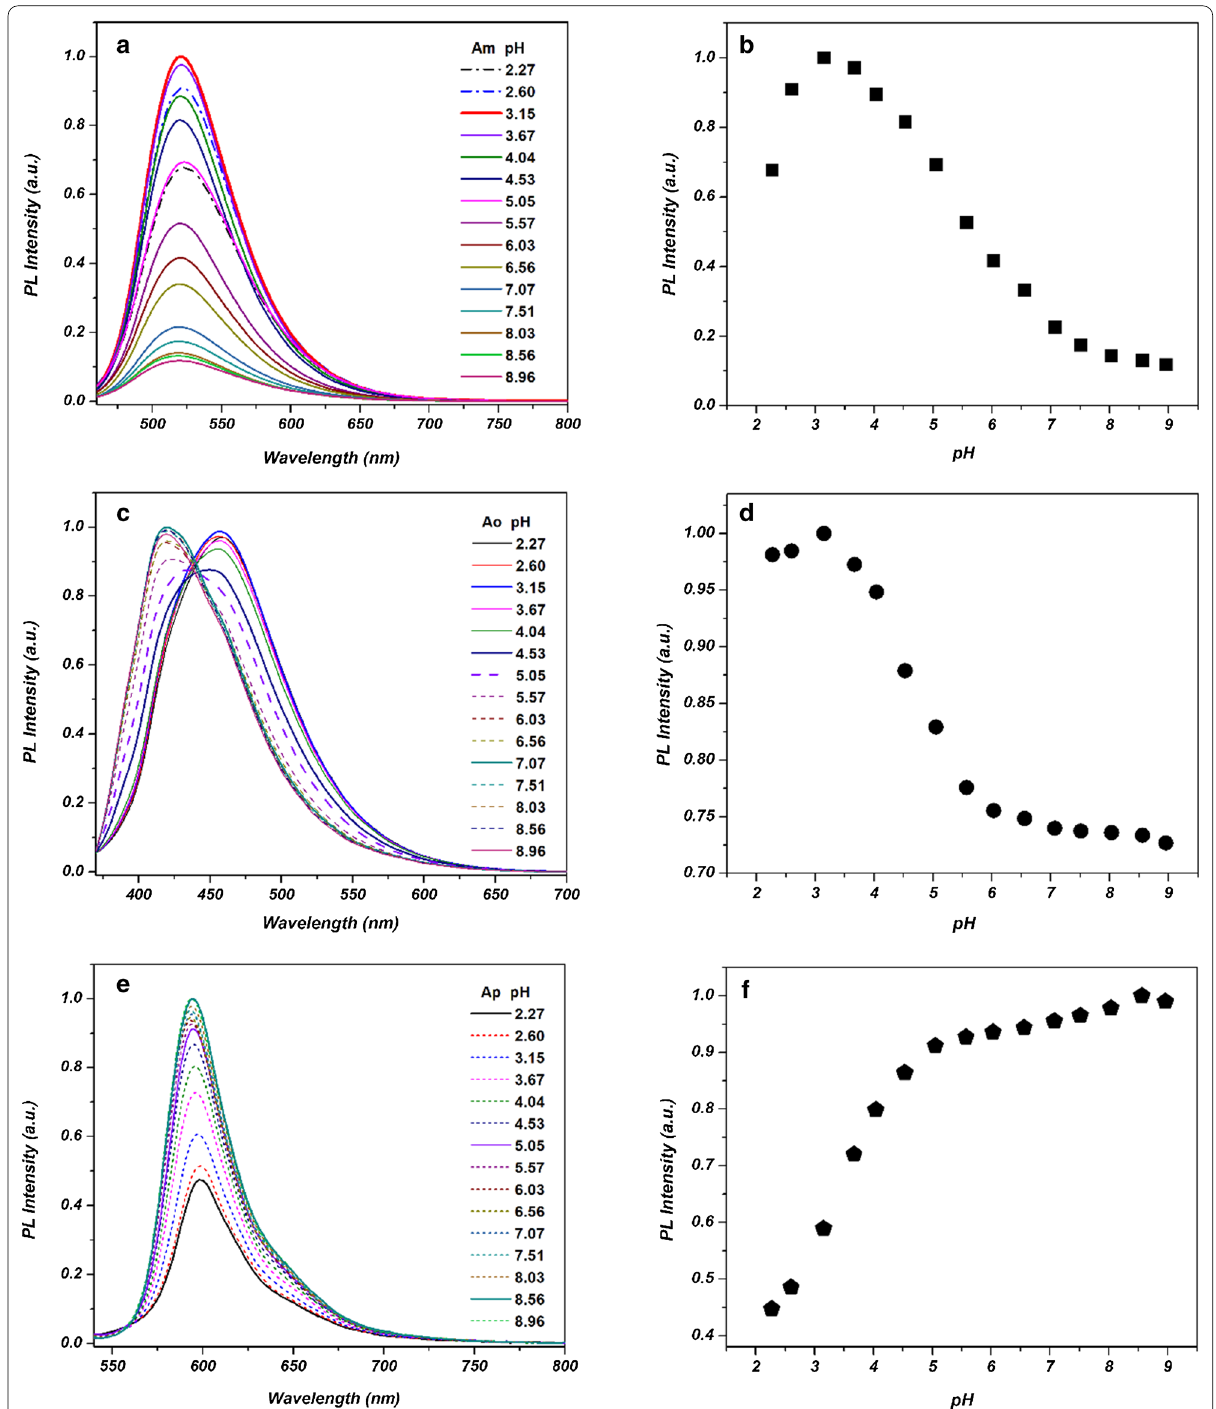
Fig. 8 PL emission and intensity change of a , b A m -CDs, c , d A o -CDs, and e , f A p -CDs under various pH